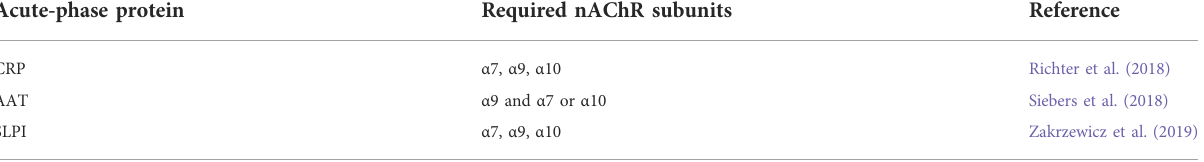
TABLE 1 Requirements and composition of nAChR subunits necessary for nicotinic signaling of acute-phase proteins in monocytic cells. Acute-phase protein Required nAChR